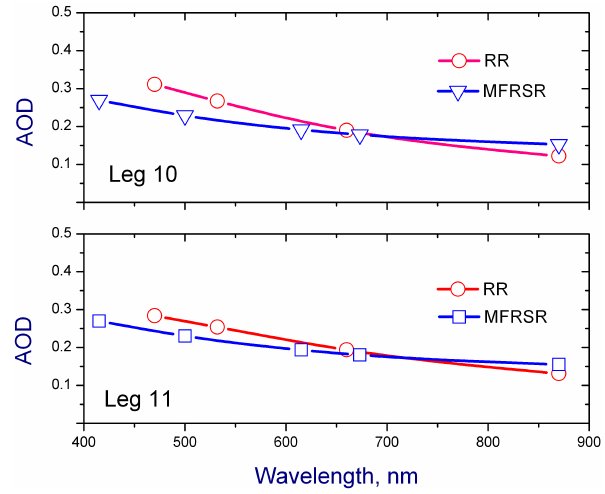
Fig. 10. Spectral dependence of the domain-averaged AOD values obtained from the RR and MFRSR retrievals for leg 10 (top) and leg 11